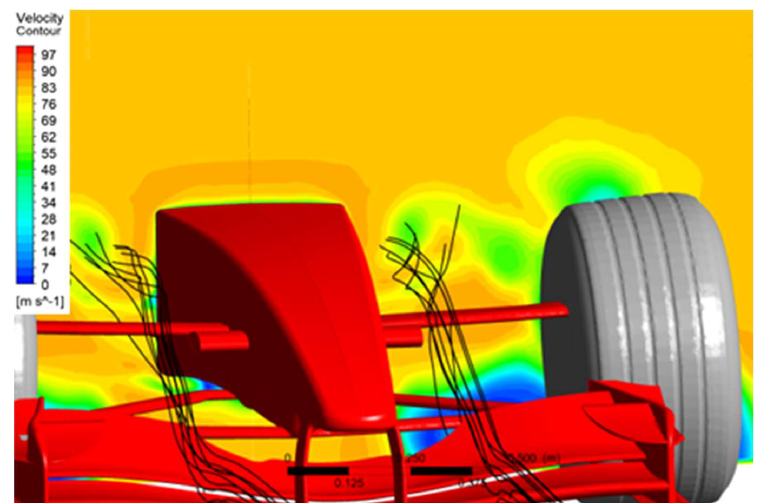
Figure 11. Vortex formation from the upper suspension.